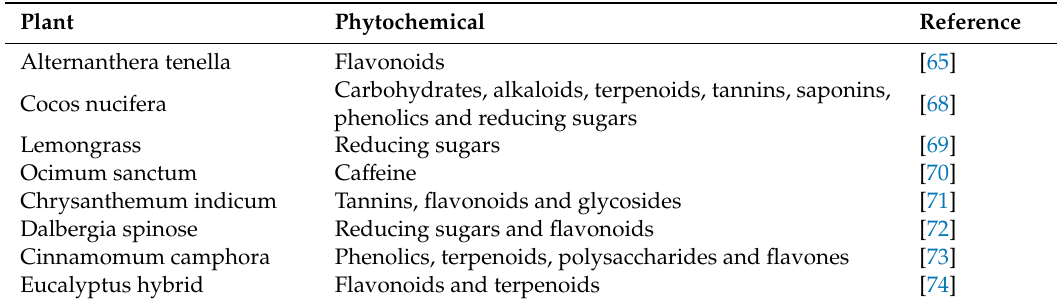
Table 1. Active phytochemical fractions associated with AgNPs synthesis in specific